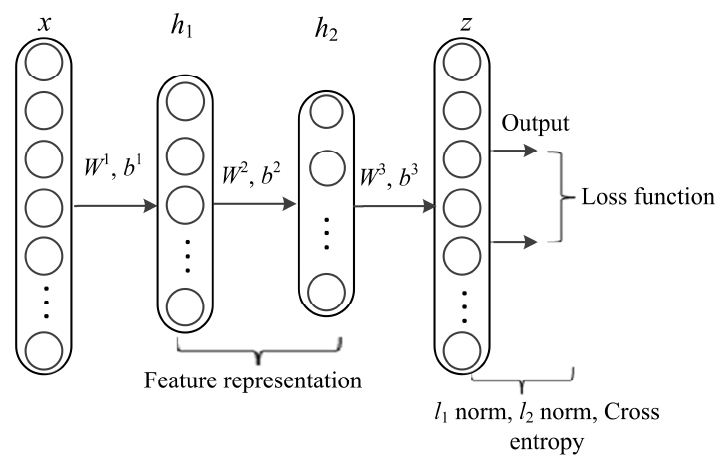
Figure 2. The network structure of constrained stacked autoencoders (AE).